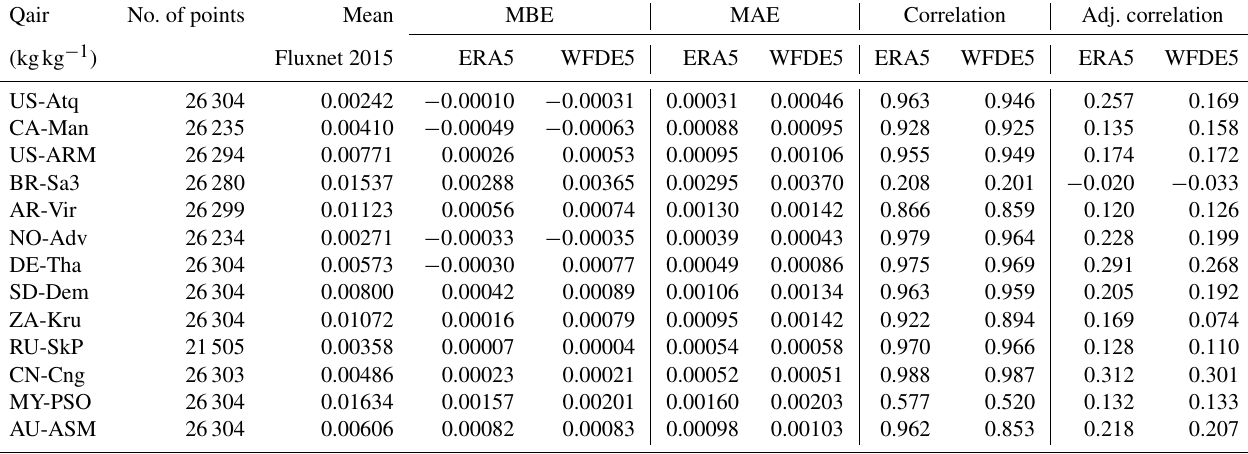
Table A3. Qair metrics for each FLUXNET2015 site: ERA5 versus FN2015 and WFDE5 versus FN2015 at hourly time steps. Qair